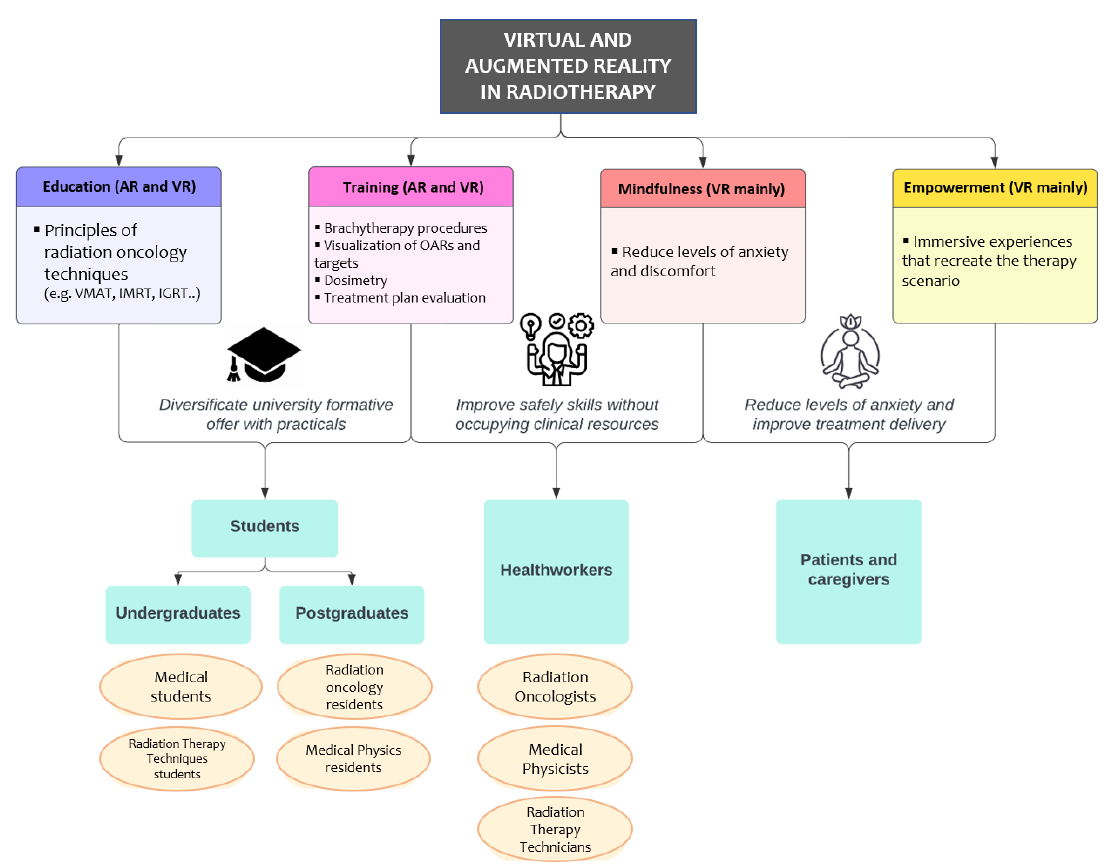
Figure 3. Overview of AR/VR applications in radiation oncology. For each field of interest, the main technologies involved are indicated in brackets. Abbreviations: AR (Augmented Reality); IGRT (Image Guided RT); IMRT (Intensity Modulated RT); OAR (Organ at Risk); RT (Radiotherapy); VMAT (Volumetric Modulated Arc Therapy); VR (Virtual Reality).